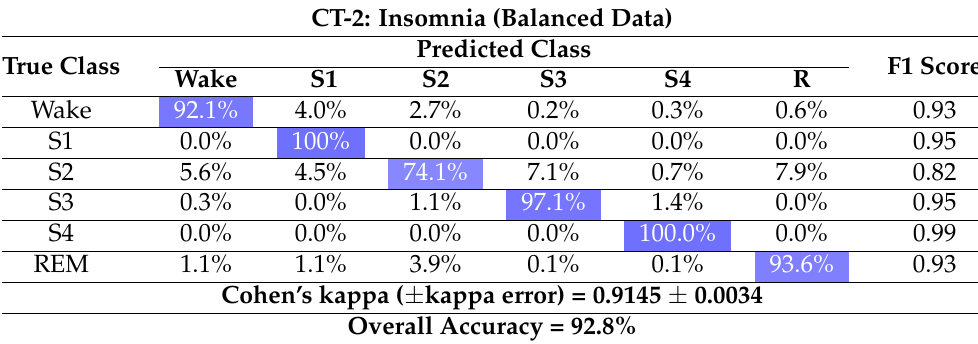
Table 12. Confusion Matrix corresponding to sleep stage classification of insomnia patients with unbalanced data using the EBT classifier with 10-fold CV.